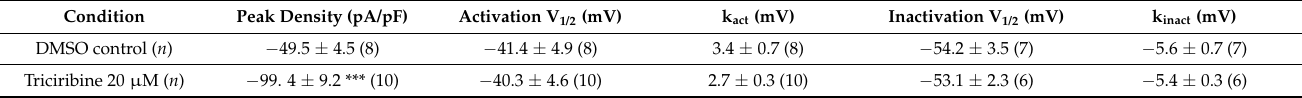
Table 2. Effects of triciribine on Na v channel properties in CA1 pyramidal cells (slice preparation) a